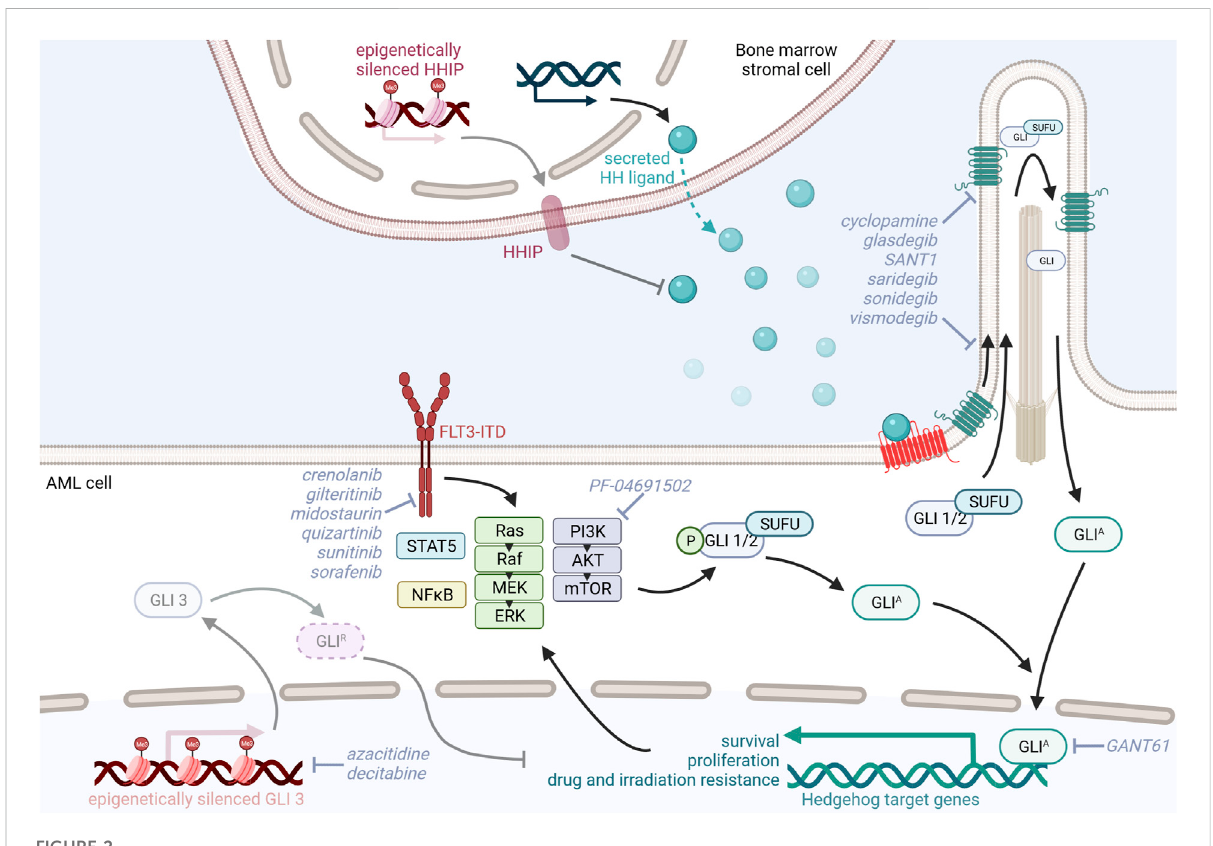
FIGURE 2 Model of oncogenic Hedgehog/GLI signaling in AML and its possible therapeutic